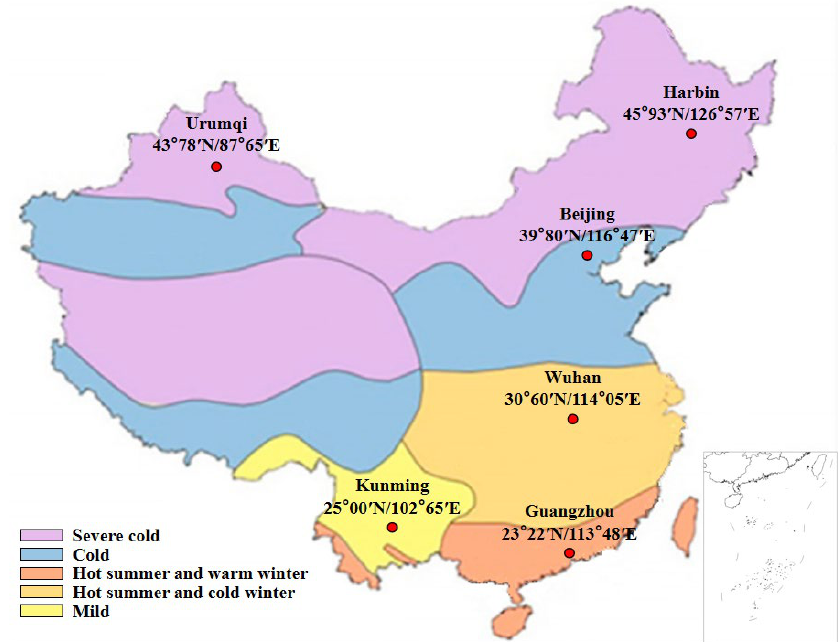
Figure 1. Geographical location information of the six typical cities.